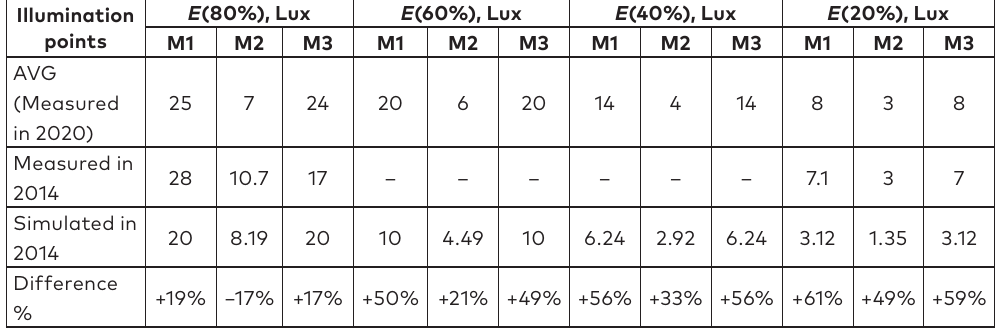
Table 6. Dialux modelling results of LITES LED